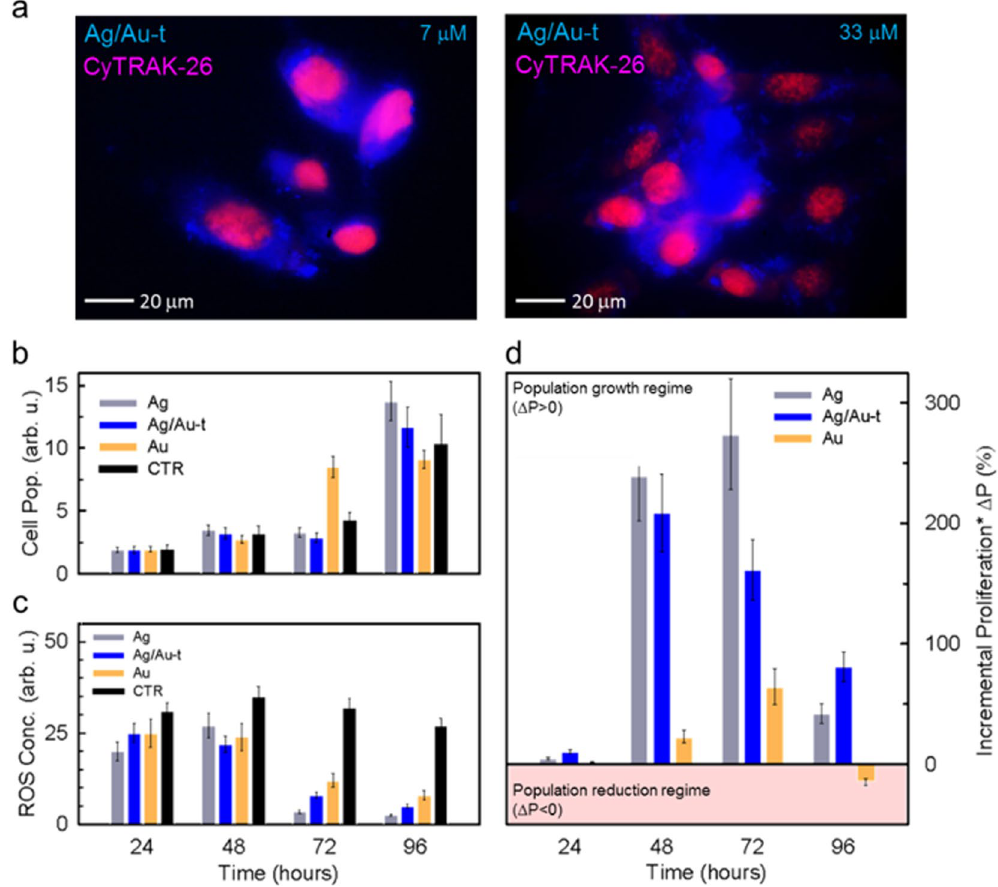
Figure 4. ( a ) Confocal fluorescence microscope images of fixed NIH/3T3 fibroblast cells co-stained with Ag/ Au-t clusters (blue) and CyTRAK-26 dye (red) under UV excitation at increasing cluster concentration (7 µ M and 33 µ M). ( b ) Cytotoxicity test and ( c ) ROS concentration level test on NIH/3T3 cells stained with 7 µ M of Ag, Ag/Au-t and Au clusters, taken at four time-points during cells proliferation (24 h, 48 h, 72 h and 96 h). ( d ) Cellular proliferation test on cells in artificially stressed culture conditions by adding the metabolic accelerator menadione. The histogram shows the incremental cell proliferation of cells stained with the metal clusters calculated with respect to the unstained control